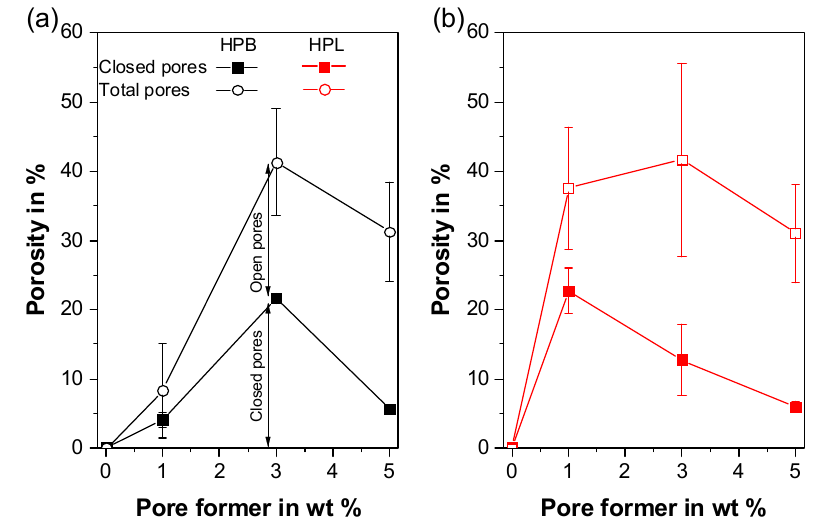
Figure 3. Total porosity and porosities derived from open and closed-cell pores respectively for all formulations comprising ( a ) hydrophobic (HPB) and ( b ) hydrophilic thermoplastic polyurethane (HPL) with and without NaHCO 3 as pore former. The lines serve for optical guidance only.